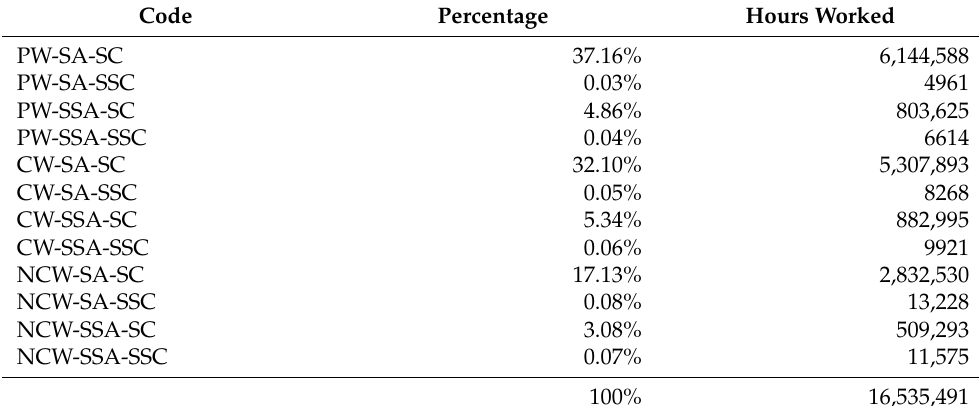
Table 11. Hours worked in a year.